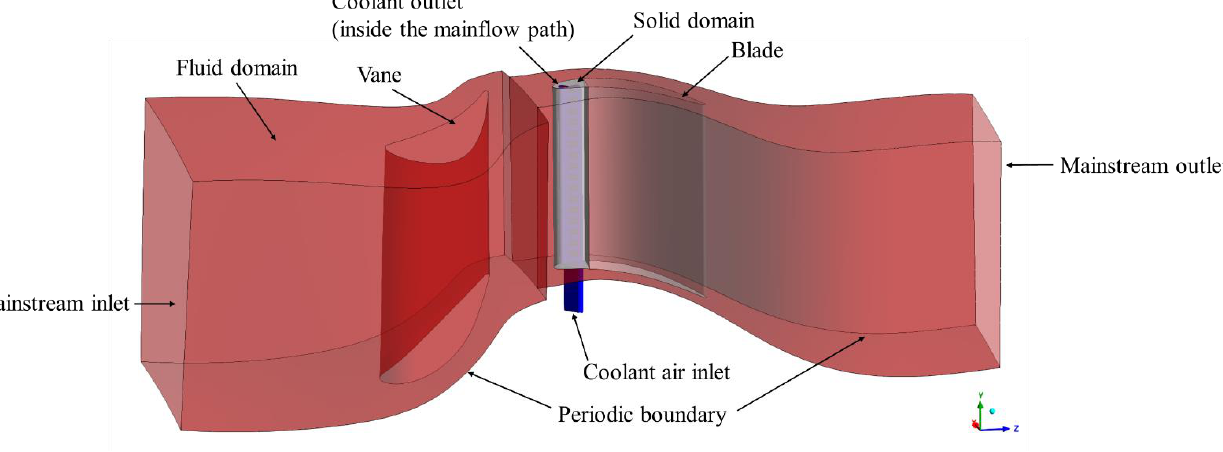
Figure 2. Computational domain.